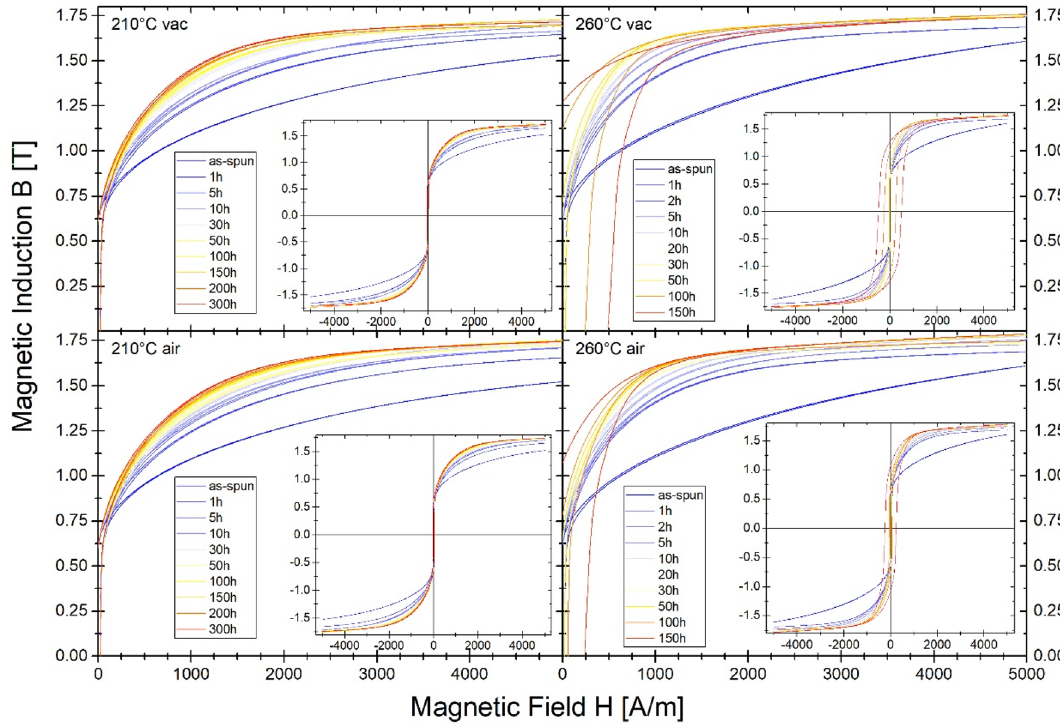
Figure 6. Evolution of hysteresis loops B(H) for vacuum and air annealed materials at 210 °C and 260 °C in different processing time.